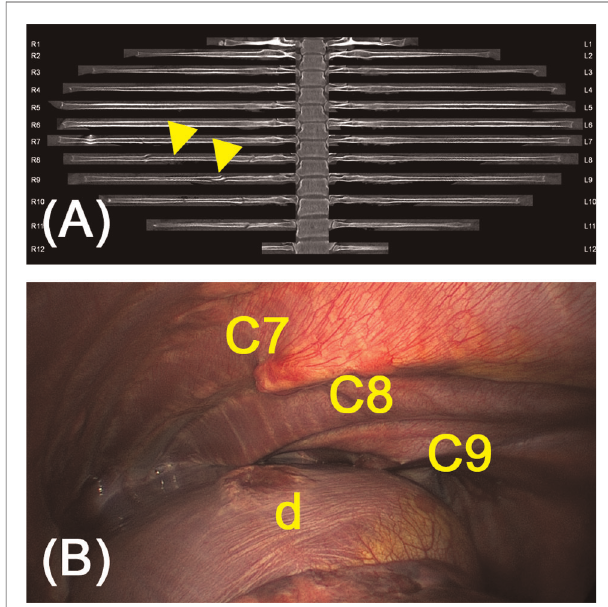
FIGURE 2 | ( A ) Curvilinear reformations of all rib pairs of a 28-year old female patient after horse accident. Serial fracture of the 8th to 11th rib on the right dorsally with a dislocation by a maximum of one rib width of the 9th rib. In addition, fractures of the 7th and 8th rib on the right laterally are leading to fl ail chest. Arrows indicate fl ail segments of costae 7 and 8 due to multiple fracture. ( B ) Intraoperative assessment showed penetrating fracture endings and a lesion of the diaphragm (d) not detected by pre-operative diagnostics.